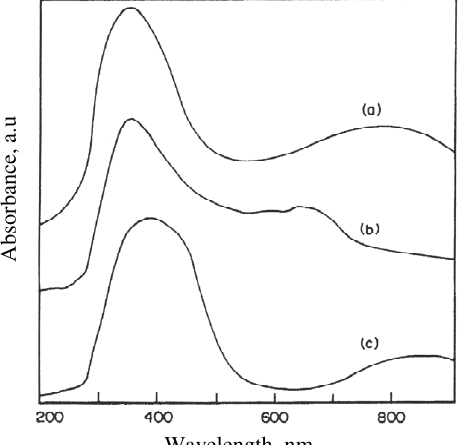
Figure 2. UV-visible spectra of polyaniline (a), poly( o -toluidine) (b) and poly( o -anisidine)